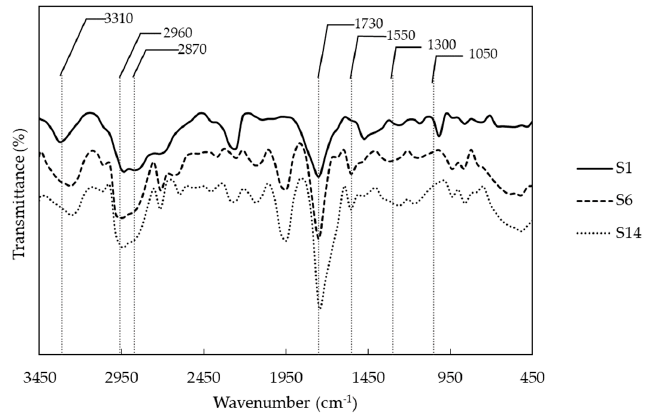
Figure 1. Representative infrared spectra of polyurethanes with different combination of polyols. (S1) PCL and PE, (S6) PCL, PEG and PE, and (S14) PEG and PE.